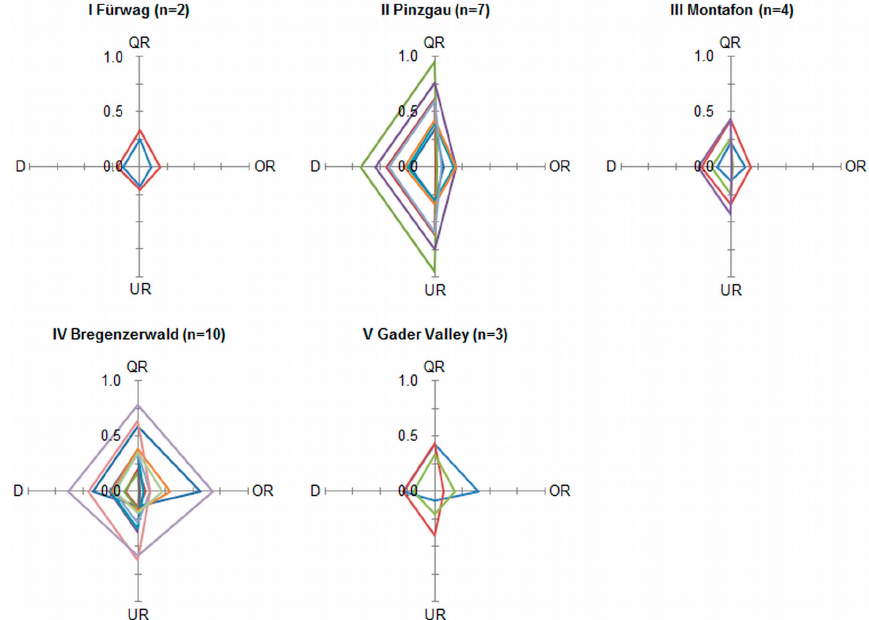
Figure 10. Landslide-specific spatial accuracy values per study site I–V. Each graph in I–V depicts the spatial accuracy signature of a detected landslide. Results presented for four metrics; Quality Rate (QR), Under-Segmentation Rate (UR), Over-Segmentation Rate (OR), and the UR-OR compound metric D.